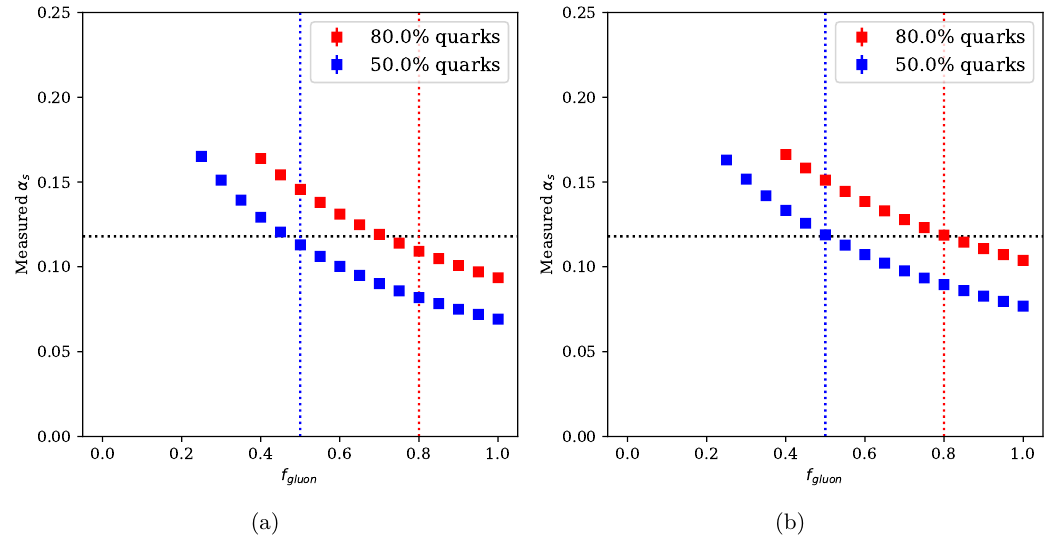
Figure 5 . Characteristic curves obtained by extracting α S from the groomed jet mass and varying the underlying sample quark/gluon composition using (a) LL and (b) NLL theory